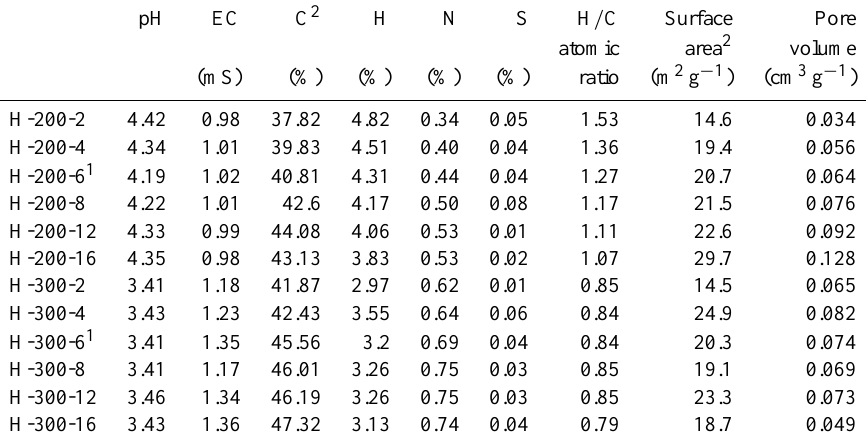
Table 2. Characterization of the hydrochar samples obtained at 200 and 300 ◦ C. pH EC C 2 H N H / C Surface Pore atomic area